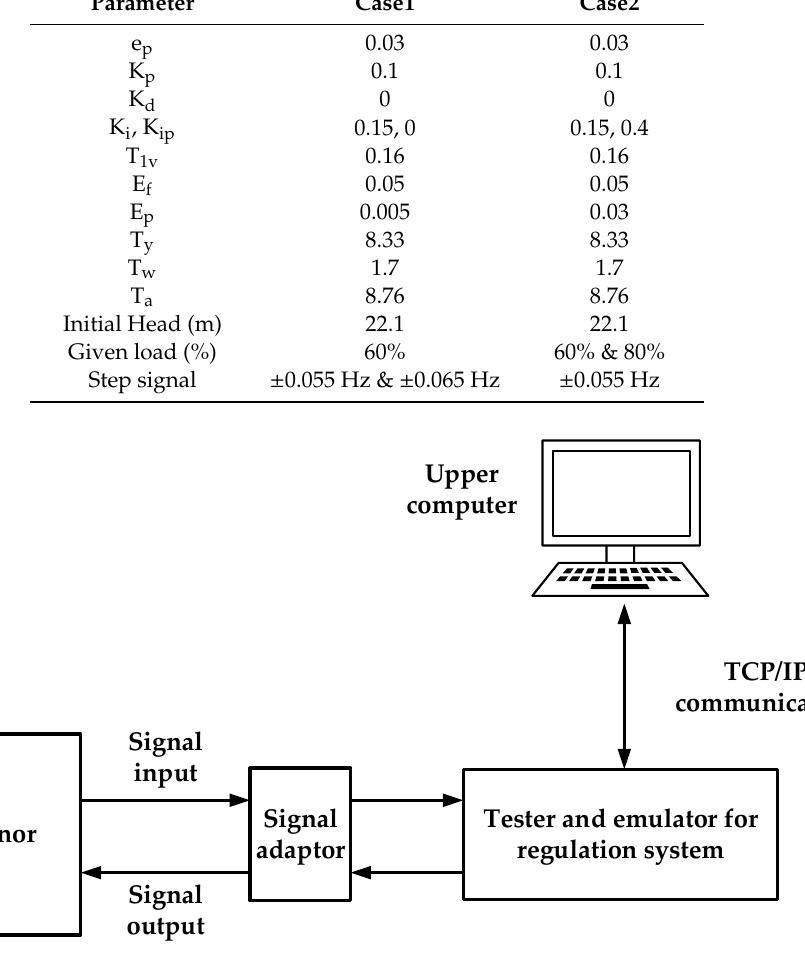
Figure A3. The hardware prototype for actual experiment. Through the instructions from Upper computer, Tester and emulator for regulation system sends frequency step signals to Governor and acquires power outputs measured by Governor, then these figures are saved in the Upper computer and displayed on the screen.